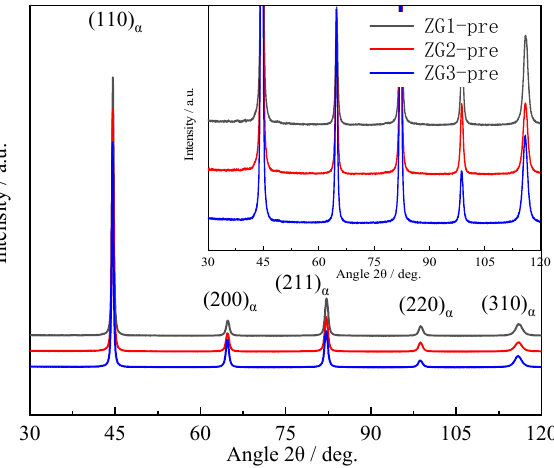
Figure 9. X-ray diffraction profiles of specimens before a thermal fatigue test.